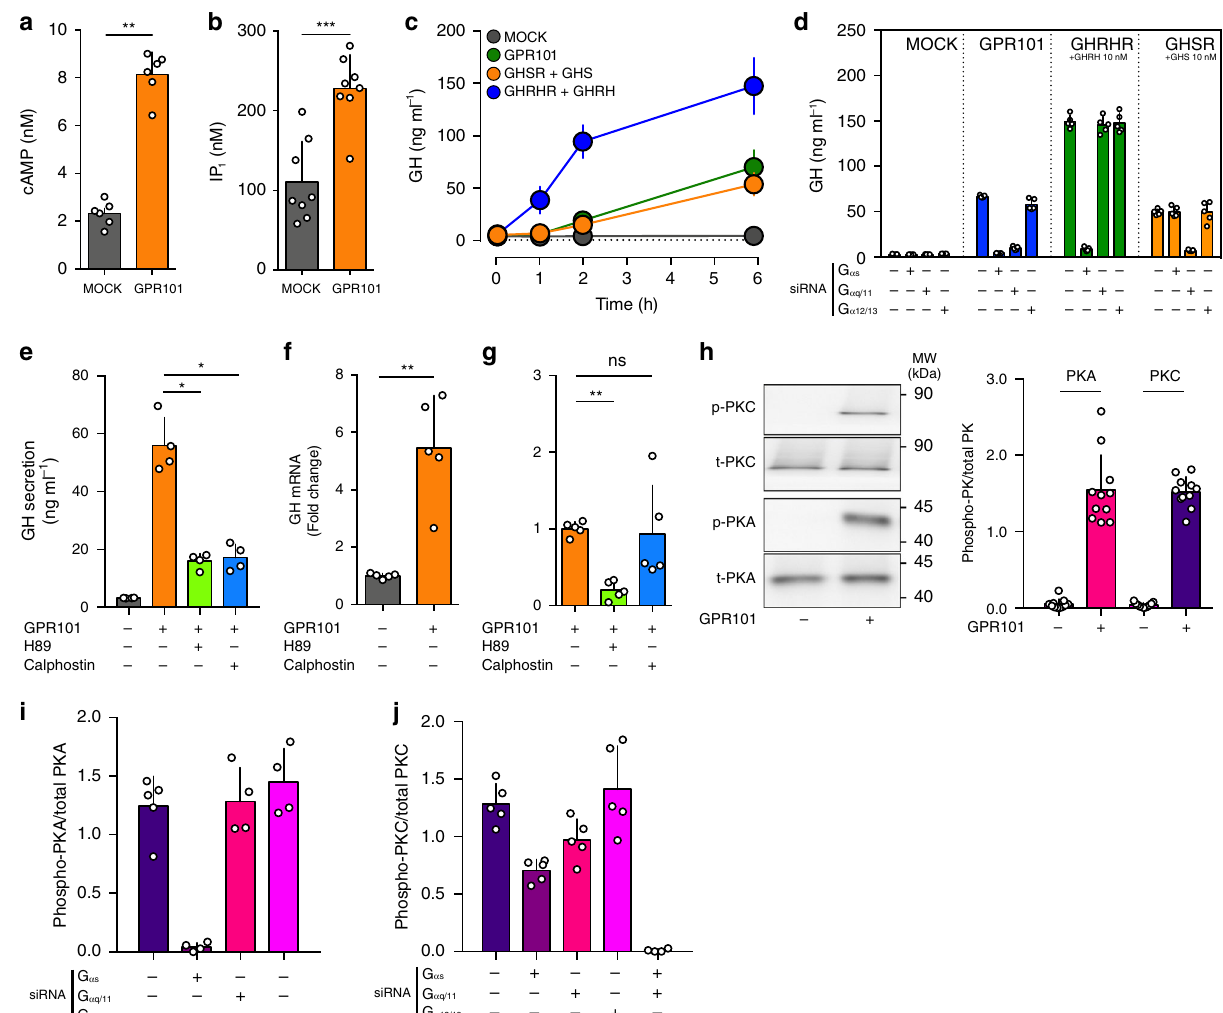
Fig. 5 GPR101 promotes GH secretion through G s and G q/11 . All the experiments presented here were performed on the GH3 pituitary cell line. a Determination of cAMP levels (by ELISA) following transient transfection with MOCK or GPR101 plasmid ( p = 0.0022). b Determination of IP 1 levels (by ELISA) following transient transfection with MOCK or GPR101 plasmid ( p = 0.0006). c Time-dependent (0, 1, 2, and 6H) measurement (by ELISA) of GH secretion in the cell culture supernatant. The cells were transfected with MOCK (dark grey), GPR101 (green), GHSR (orange), or GHRHR (blue) for 24 h, then starved for 3 h. For GHSR and GHRHR, cells were stimulated with their respective ligands (GHS or GHRH, 10 nM). GPR101 and MOCK received a vehicle treatment as control. d GH determination in the cell culture supernatant after 24h-treatment with various siRNAs (G α s , G α q/11 , or G α 12/13 ), 24h- transfection with expression plasmids containing receptors (MOCK, GPR101, GHSR, or GHRHR), 3h-starvation and 6h-stimulation with indicated agonists (GHS or GHRH, 10 nM). e GH secretion was determined (by ELISA) in the cell culture supernatant following transfection with GPR101 (or MOCK) and treated with vehicle, H89 (10 µ M, p = 0.0286) or Calphostin (10 µ M, p = 0.0286). f , g Rat GH mRNA determination by RT-qPCR following transfection with MOCK or GPR101 ( p = 0.0079) ( f ) and treatment with PKA & PKC inhibitors H89 (10 µ M, p = 0.0079) and Calphostin (10 µ M, p = 0.6905) ( g ), respectively. h Left: Immunoblot for the detection of phosphorylated PKA and PKC in GH3 cells following transfection with MOCK or GPR101. Right: Quanti fi cation by densitometry of immunoblots. Normalization was performed compared to total PKA and PKC proteins in cell lysate. Full scans of blots are available in the Source Data fi le. I , j Quanti fi cation by densitometry of immunoblots for PKA and PKC in the presence of GPR101 and different siRNAs. The antiphosphorylated antibody has been normalized to the signal from the antibody against total protein. All data are Mean ± S.D. of n = 8 ( b ), n = 6 ( a , c ), n = 5 ( d , f , g , j ), n = 4 ( e , i ), and n = 3 ( h ) independent experiments. For statistical analysis of all data, a two-sided Mann – Whitney test was used. ns